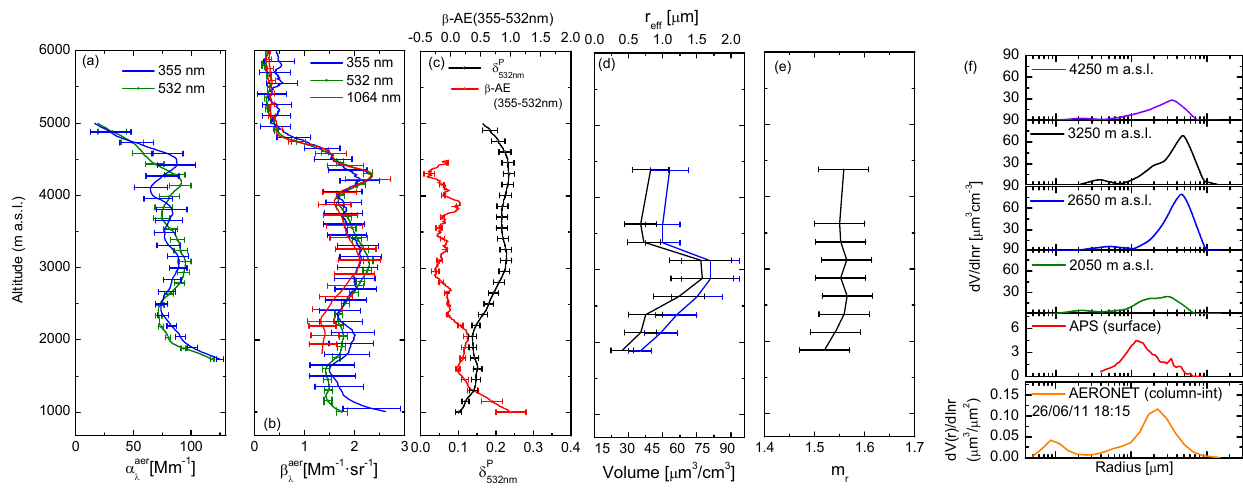
Figure 5. (a) β aer and α aer retrieved with Raman technique and (b) derived β -AE(355–532nm) and δ P 532nm 532nm the 27 June 2011. (c) Total volume concentration, r eff and (d) m r retrieved for the same period with the regularization technique applied to the 3 β + 2 α + 1 δ lidar data and (e) Volume–size distributions retrieved at different height levels using the APS (surface level) and the regularization technique applied to the 3 β + 2 α + 1 δ lidar data at 00:00–01:00UTC on the 27 June 2011. Column-integrated AERONET size distribution corresponding to the 26 June 2011 at 18:15UTC is included